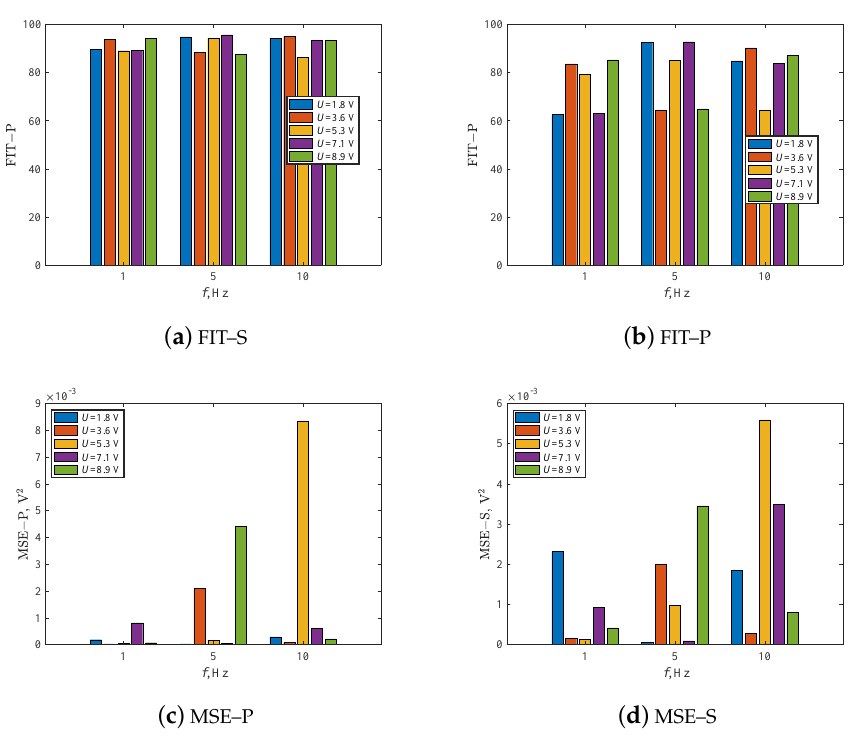
Figure 10. Quality metrics vs. voltage